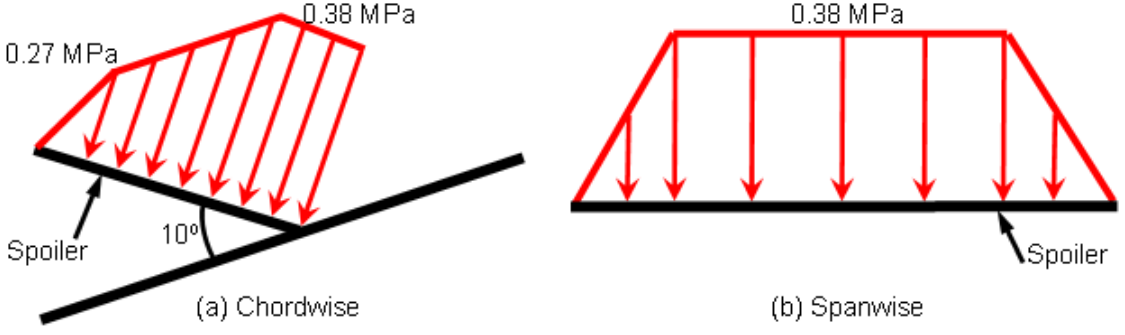
Figure 2. Pressure distribution along chordwise and spanwise directions.